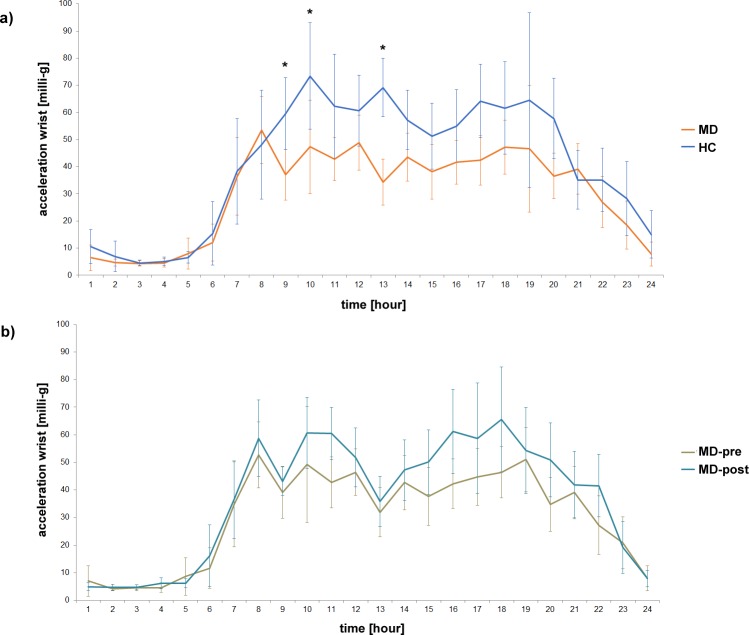
Diurnal variation of motor activity measured at the wrist a) in MD patients at the beginning of treatment (MD) and healthy controls (HC) as well as b) in MD patients at the beginning (MD-pre) and after 4 weeks of inpatient treatment (MD-post).* show significant differences in hours analysed with post-hoc test (Newman-Keuls).